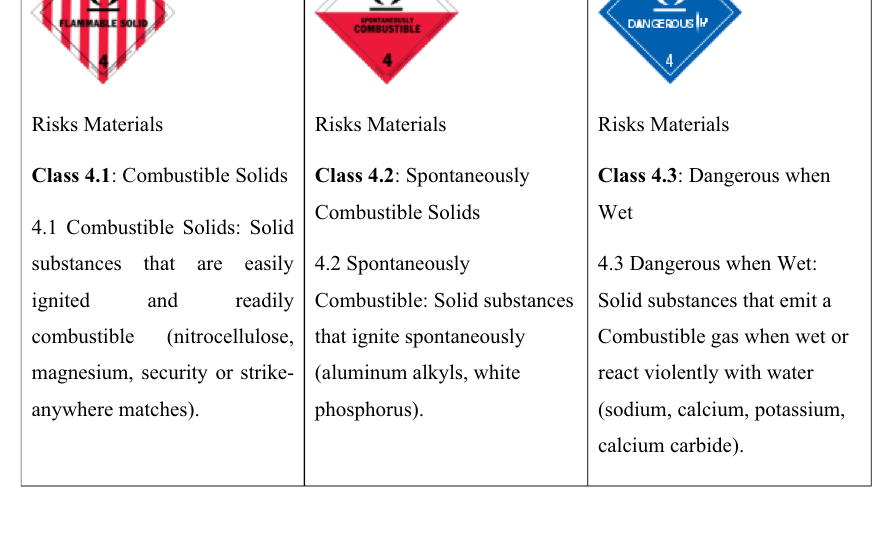
Fig. 5 Class 5, Oxidizing agents and organic